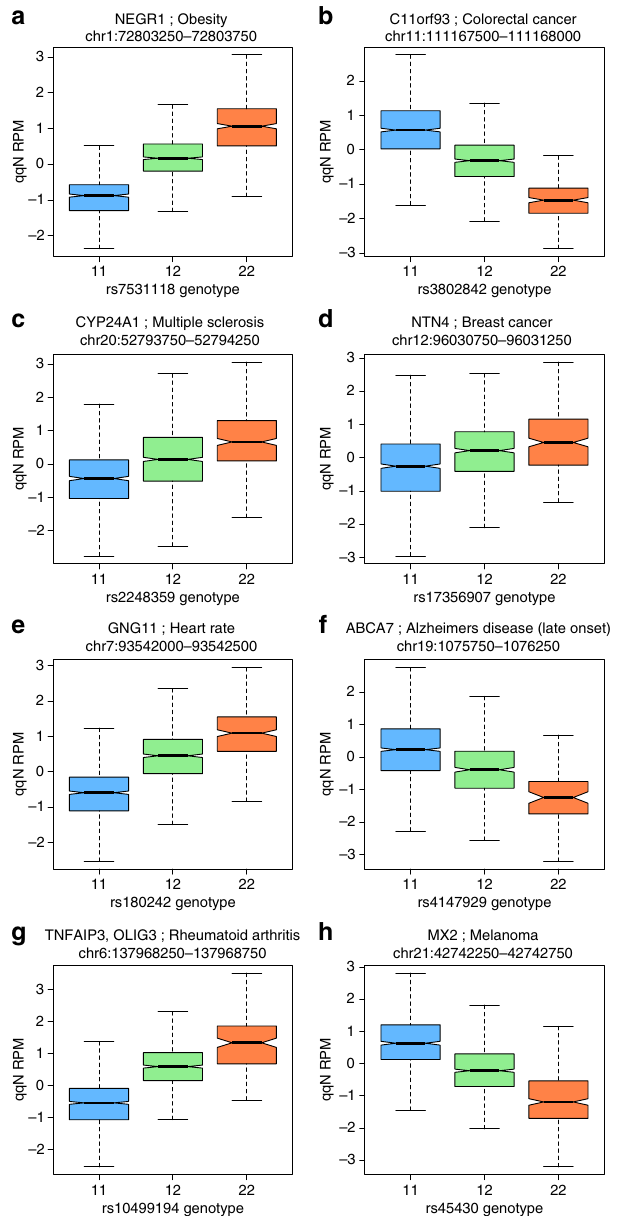
Fig. 4 Variation by genotype within selected HSM peaks. Boxplots of most signi fi cant 500 bp windows within HSM peaks from within selected the GWAS LD block regions from Fig. 3. Normalised reads per million DNA methylation ( y -axis: qqN RPM) within window by genotype for the GWAS SNP ( x -axis: Genotype categories represented as 11, 12 and 22). a NEGR1 obesity locus, rs7531118; b intergenic colorectal cancer, rs3802842; c CYP24A1 multiple sclerosis, rs2248359; d NTN4 breast cancer, rs17356907; e GNG11 Heart Rate, rs180242; f ABCA7 Alzheimer ’ s